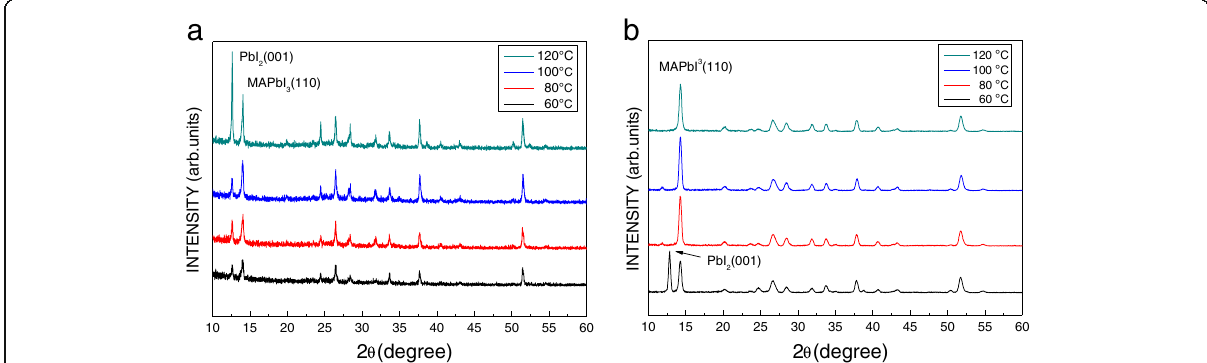
Fig. 4 XRD patterns of the MAPbI 3 films with a low- and b high-concentration